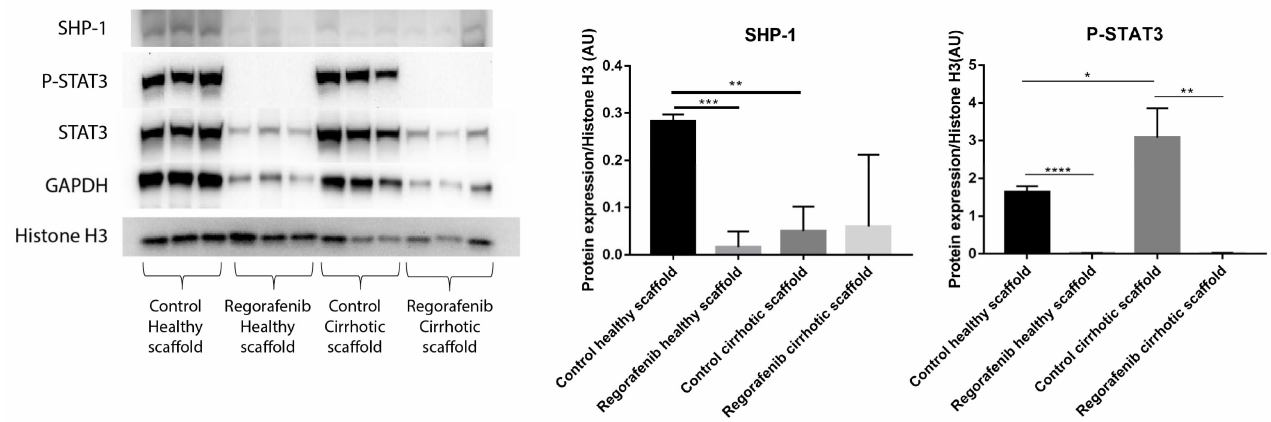
Figure 7. Protein expression of LX2-HepG2 co-cultures treated with Regorafenib compared to control in healthy and cirrhotic 3D scaffolds. Western blot and densitometry analysis of SHP-1, P-STAT3, STAT3 and GAPDH protein expression of LX2 and HepG2 cells co-cultured in healthy and cirrhotic 3D liver scaffolds treated with Regorafenib 16.6 µ M for 6 days compared to internal controls ( n = 4 scaffolds per condition, * p ≤ 0.05, ** p ≤ 0.01, *** p ≤ 0.001, and **** p ≤ 0.0001). (Figure S1: Whole blot showing all the bands with all molecular weight markers on the